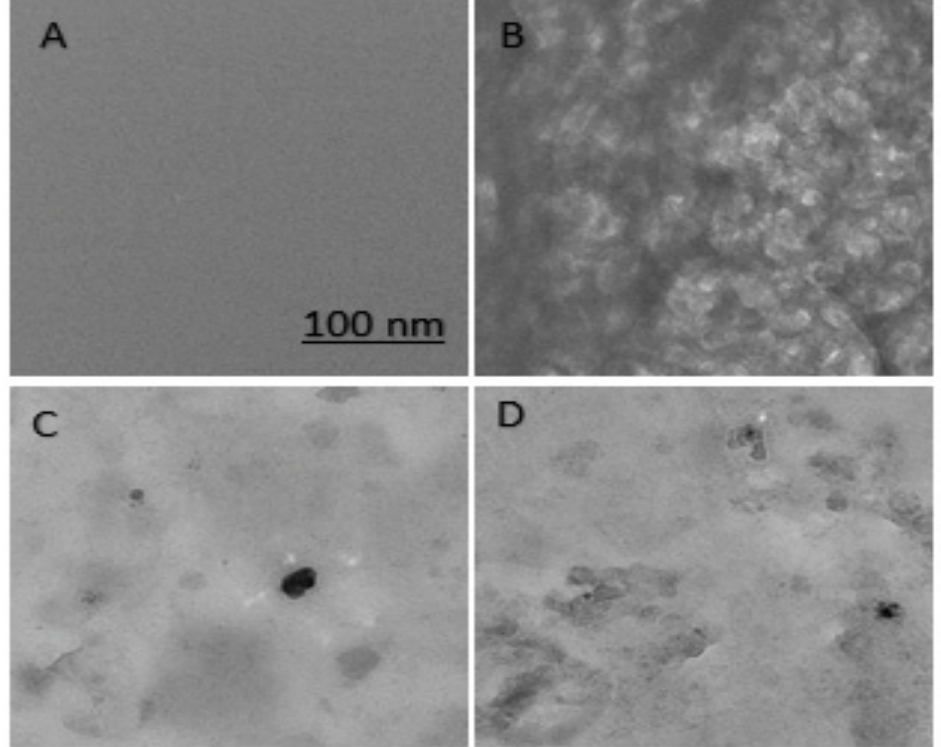
Figure 6. Transmission electron microscopy analysis of incubated samples for native HSA, HSA with 5 M urea, and HSA with 5 M urea in the presence of 35 µg/mL ( w / v ) B-AgNPs and 55 µg/mL ( w / v ) ( A – D ) respectively. The image is observed at 20,000X magnification at scale bar of 100 nm.